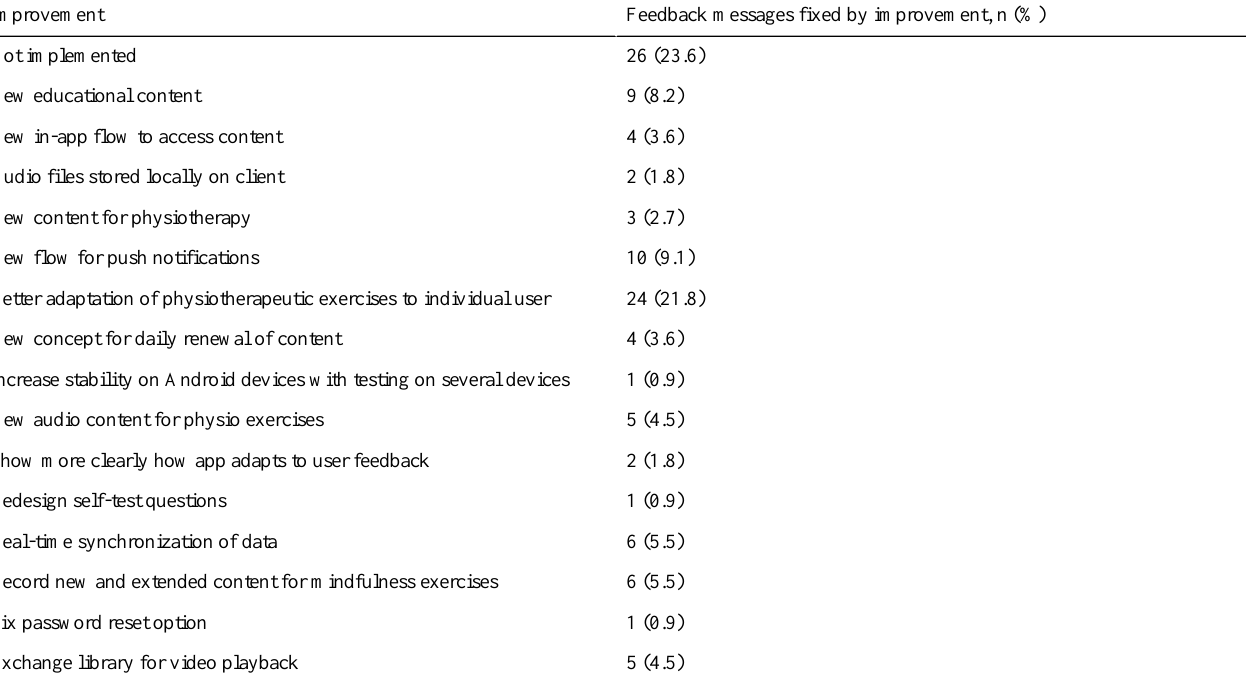
Table 2. Improvements in version 1.x with number of feedback issues fixed by individual improvements.